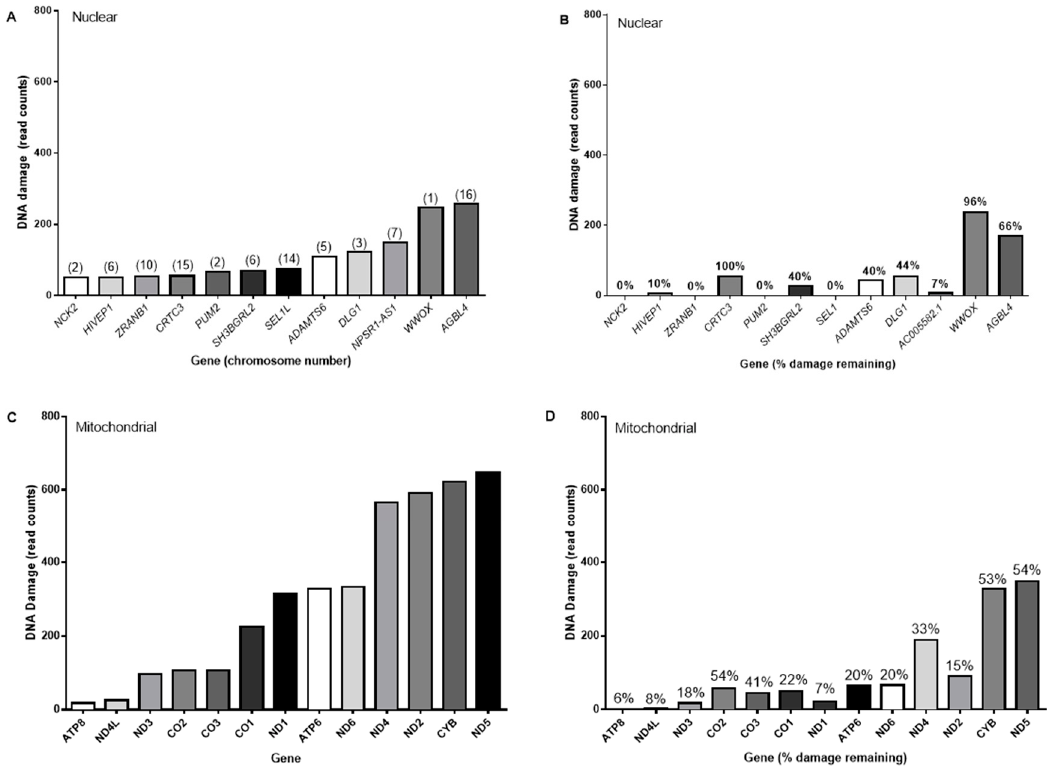
Figure 6. Levels of solar simulated radiation induced T<>T (read counts) in representative ( A ) nuclear, and ( C ) mitochondrial genomic regions, immediately and ( B and D , respectively) 24 h after exposure to SSR. In Figure 6 ( A ), the corresponding chromosomal location is given in parentheses for the nuclear loci. Indicated in Figures 6 ( B ) and ( D ) is the percentage of damage remaining, relative to initial amounts in their corresponding figures (Figures 6 A and C, respectively).